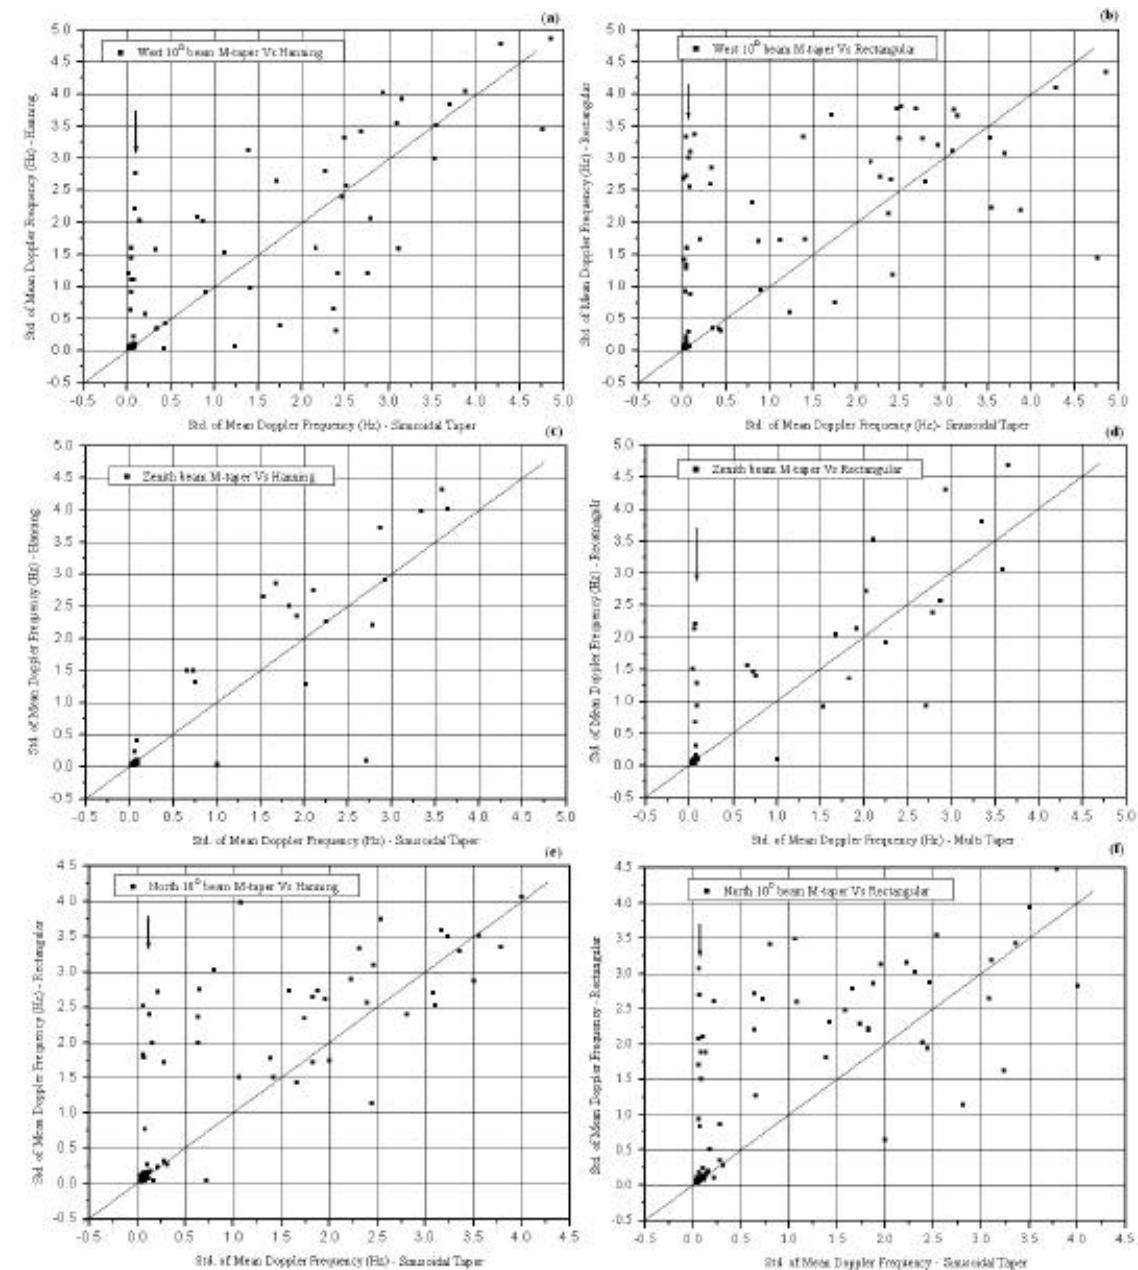
Figure-4 Fig. 4. Comparison of standard deviation of mean Doppler frequency between sinusoidal taper, vs. Hanning taper, and sinusoidal taper vs. rectangular taper, (a) and (b) for west 10 ◦ beam, (c) and (d) for zenith beam, (e) and (f) for north beam, respectively, observed on 11 April